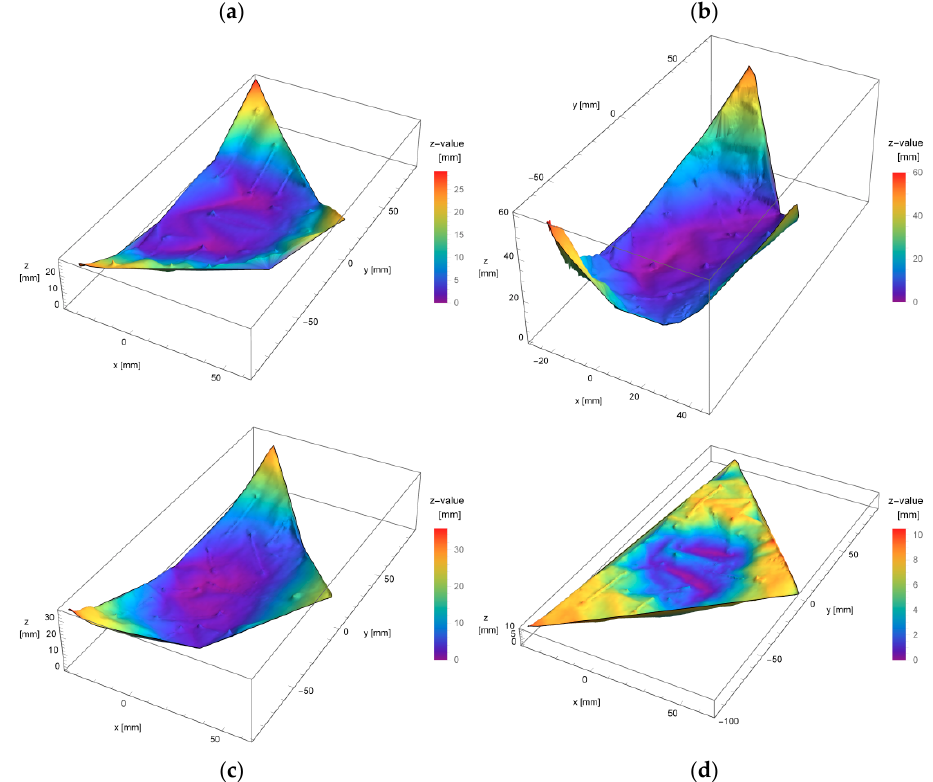
Figure 5. Open layout of the sails after alignment, respectively, in Configuration 1 ( a ), 2 ( b ), 3 ( c ), and 4 ( d ). 4 ( d